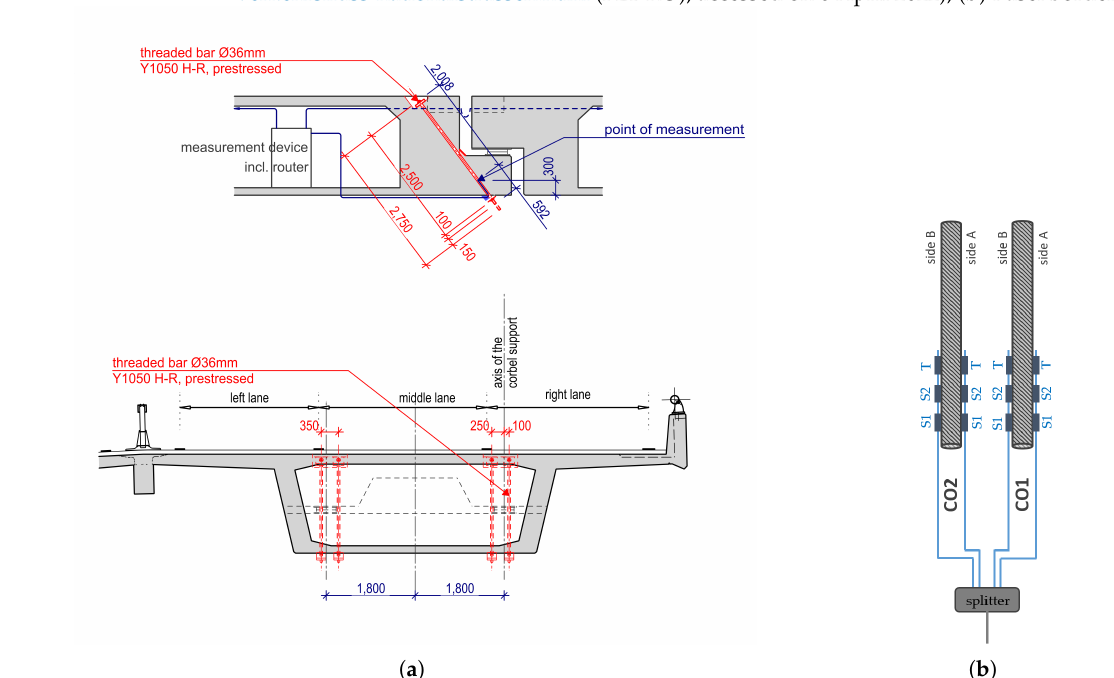
Figure 2. ( a ) Position of the pre-stressed threaded bar at the Gerber joint, cross-section of the bridge in one direction of travel; ( b ) strain (S1 and S2) and temperature (T) sensors on two parallel